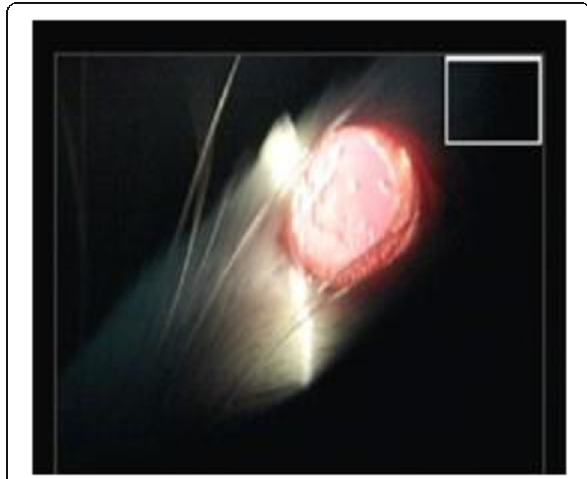
Fig. 2 Slit lamp photography of untreated diabetic model of group 2 showing stage 3 cataract changes with equatorial vacuoles and granular deposits on the anterior surface in the lens